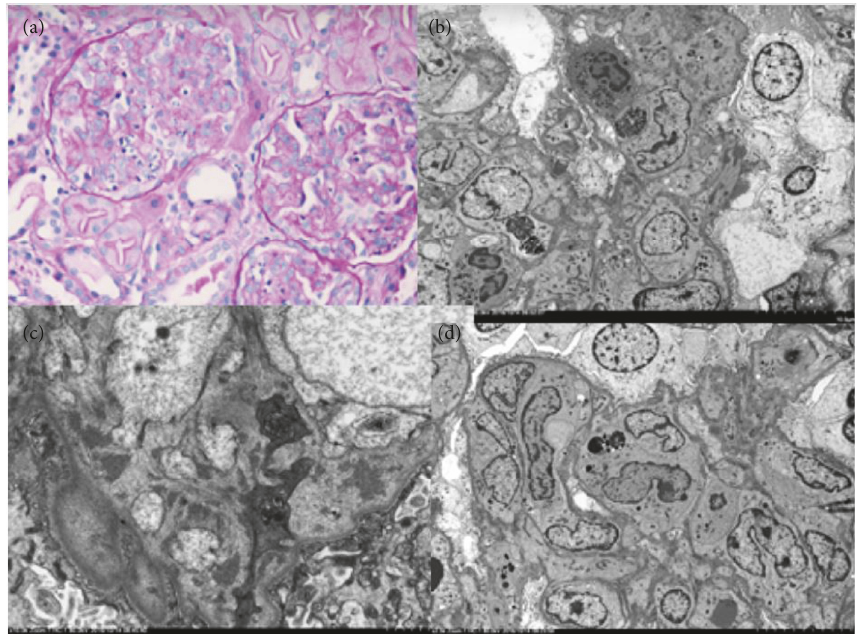
Figure 2: Renal biopsy. (a) Acute diffuse proliferative glomerulonephritis with intracapillary neutrophils and closure of glomerular capillaries andinfiltrationofcapillaries.(b)and(c)Portionofglomerusshowsintracapillaryinflammatorycells,swellingofendothelialcells,mesangium, and subendothelial and (d) rare subepithelial dense deposits.